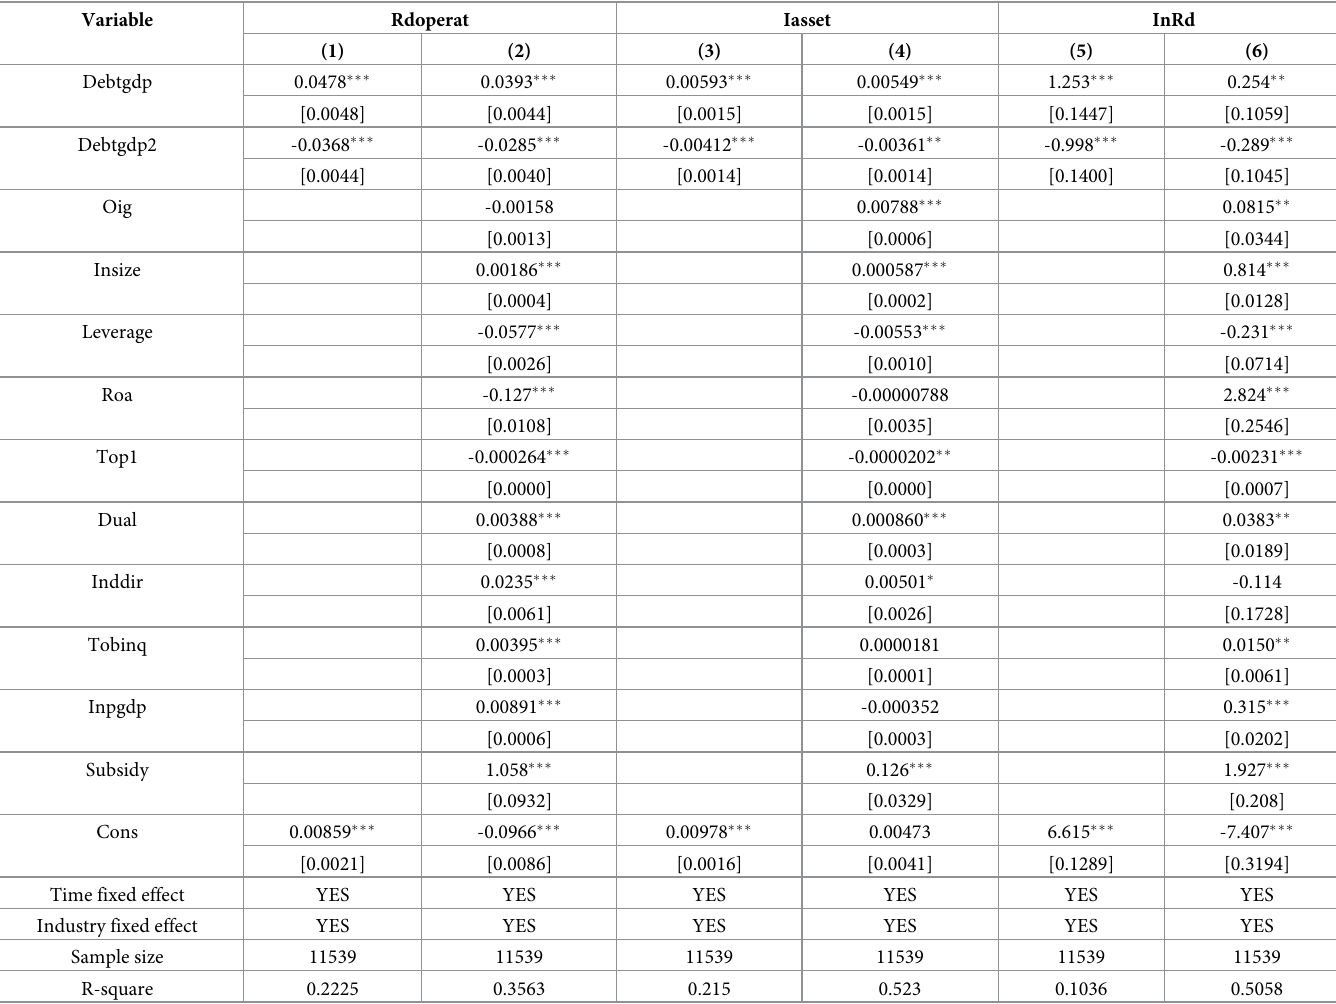
Table 2. Regression results of local government debt impacting enterprise